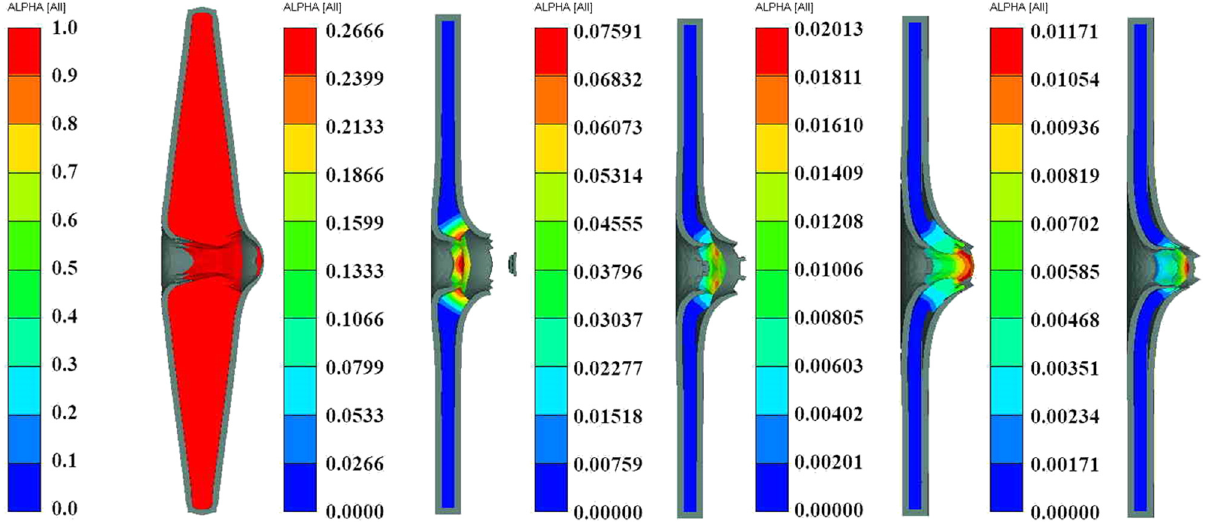
Figure 10: Reactivity of the ERA impacted by PTFE jets at di ff erent stando ff